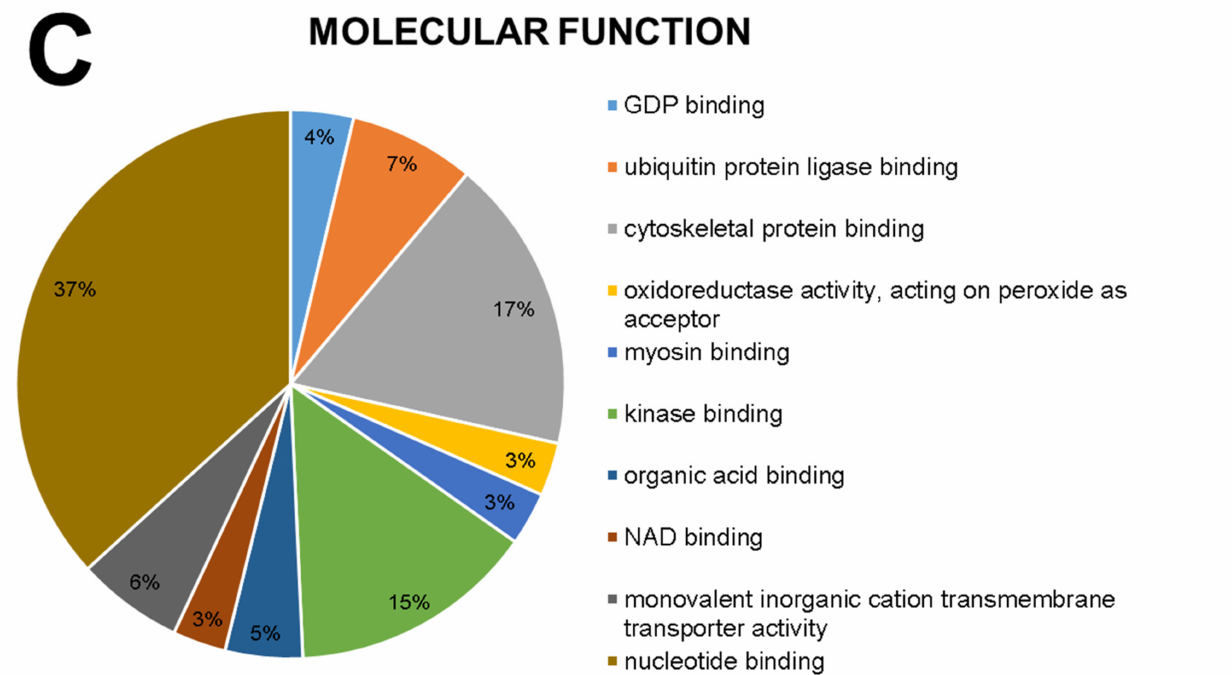
Figure 1. Distribution of proteins with different expressions in ( A ) Cellular Component ( B ) Biological Process ( C ) Molecular Function of rats exposed to AlCl 3 vs. control. Categories of proteins are based on Gene Ontology annotation of the biological process. Protein accession numbers were provided by Uniprot.org. The gene ontology was evaluated according to the ClueGo plugin of Cytoscapes software 3.6.